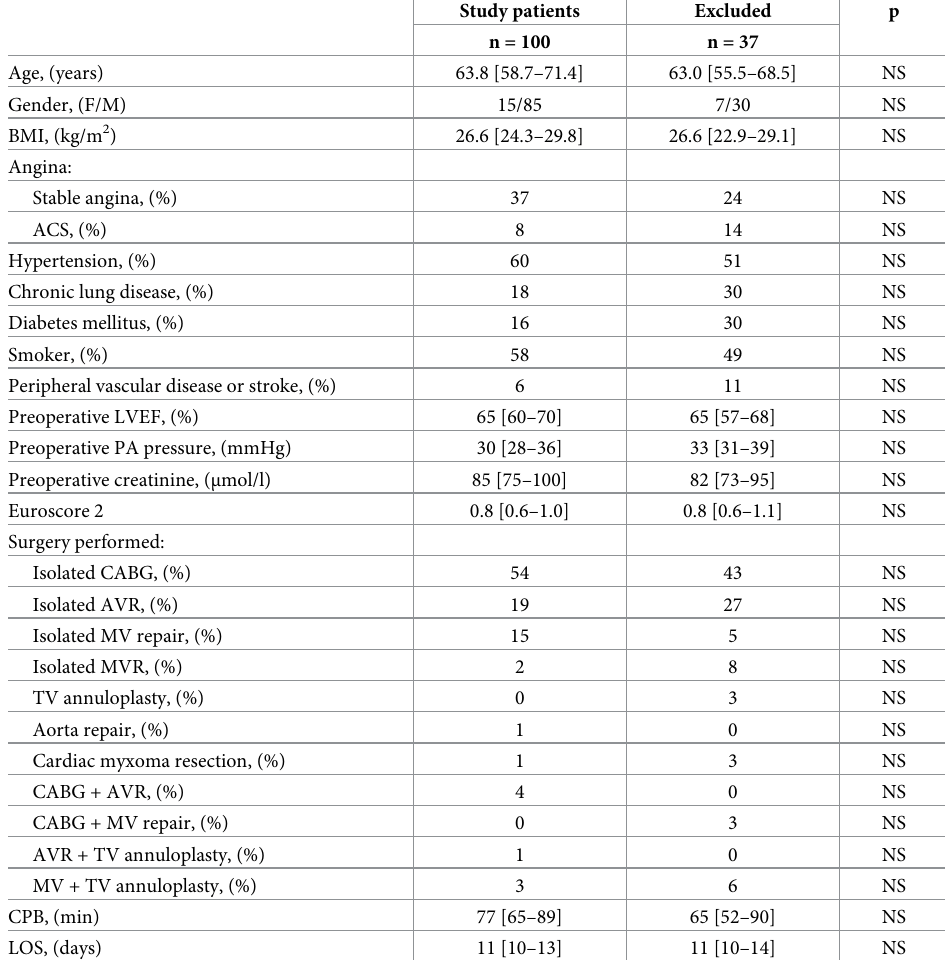
Table 1. Main patient perioperative